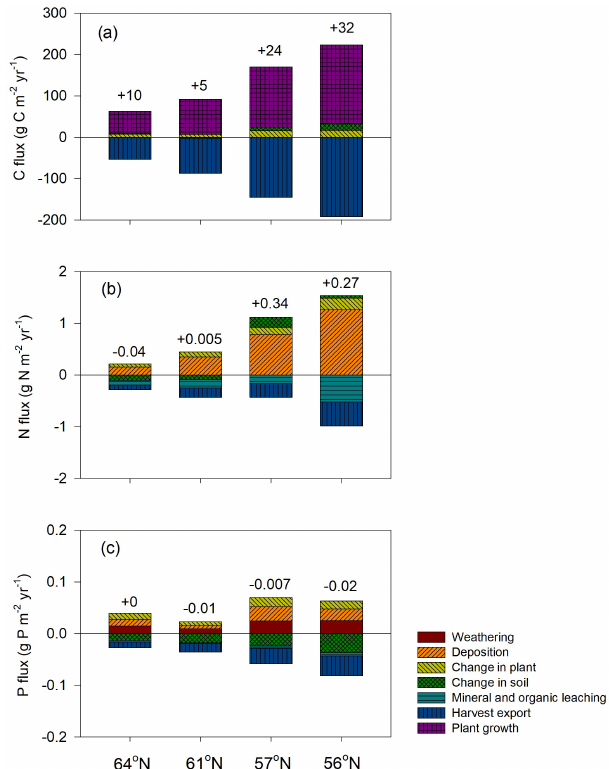
Figure 4. Simulated mean annual fluxes in (a) C, (b) N, and (c) P in the four regions. The numbers above the stacks indicate the annual mean change in the ecosystem. The simulation period starts from year 10 and ends 10 years after final felling. Plant growth in (a) represents net primary